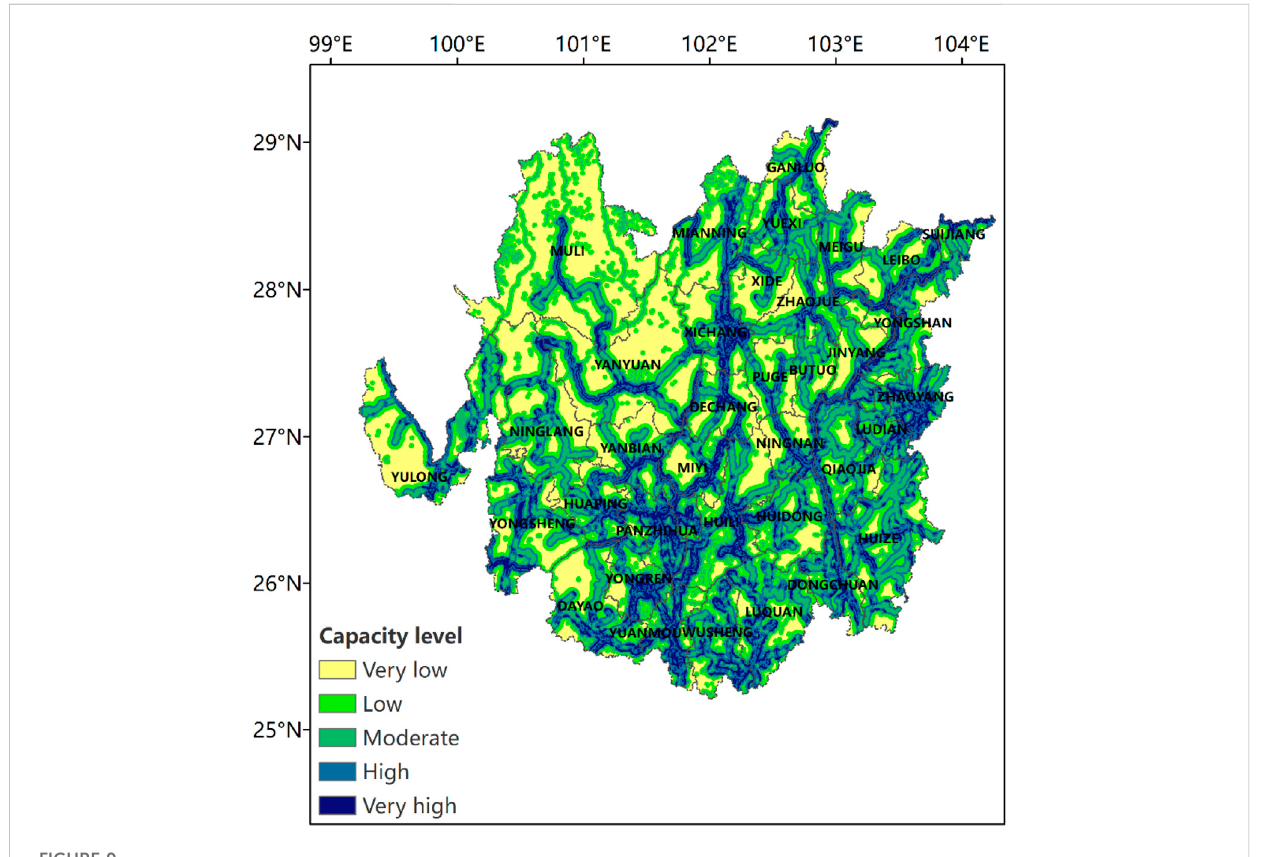
FIGURE 9 Spatial pattern of wild fi re prevention/mitigation